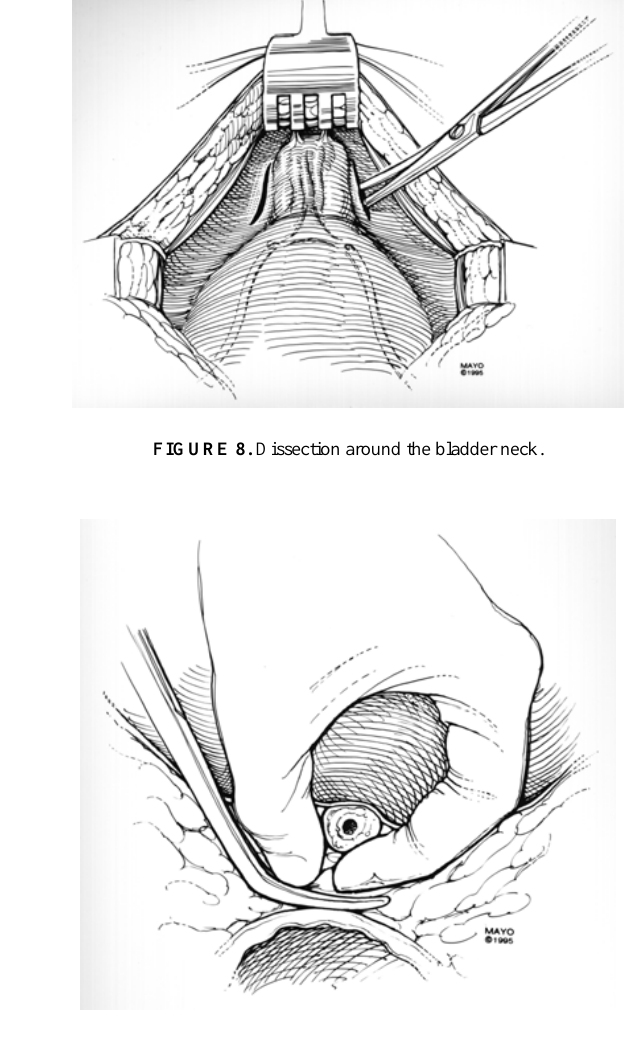
FIGURE 9. Developing the plane superior to the endopelvic fascia but distal to the posterior aspect of the bladder